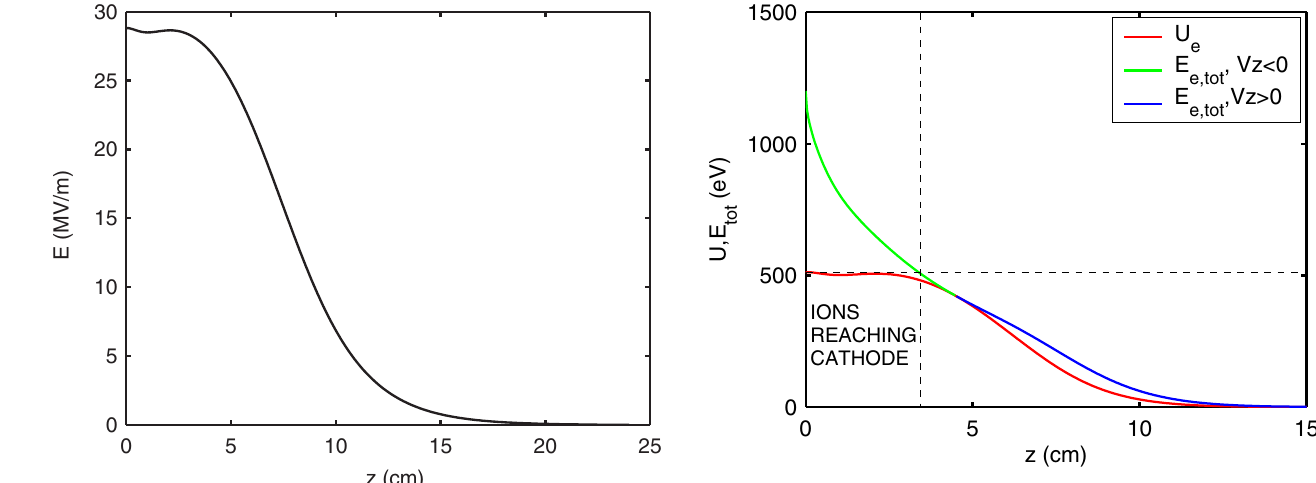
FIG. 2. Longitudinal electric field on the gun axis. The longi- tudinal coordinate z ¼ 0 corresponds to the cathode